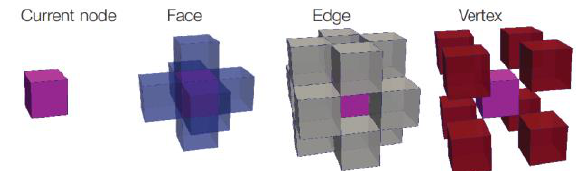
Figure 3: Sharing a common face (6), edge (12), or vertex